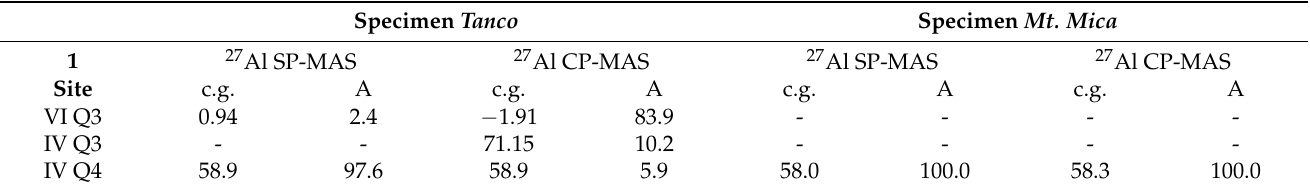
Table 6. NMR parameter of the 27 Al spectra at 9.4 T of two specimens of